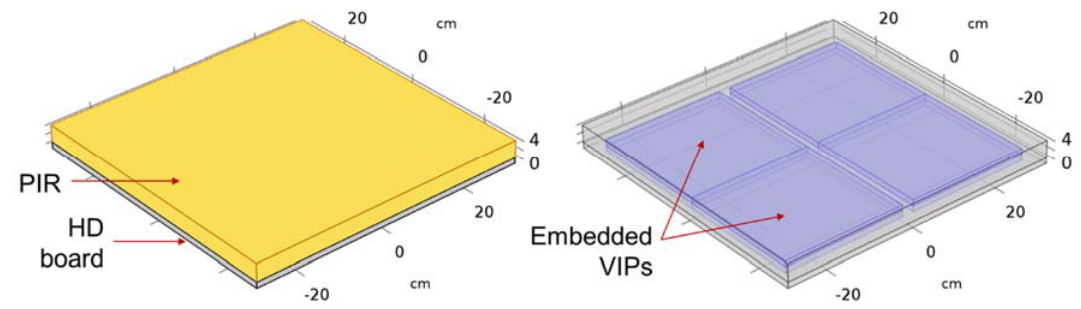
Figure 6. Model of composite ‘c’ with VIPs embedded within PIR (polyisocyanurate) foam and HD board.